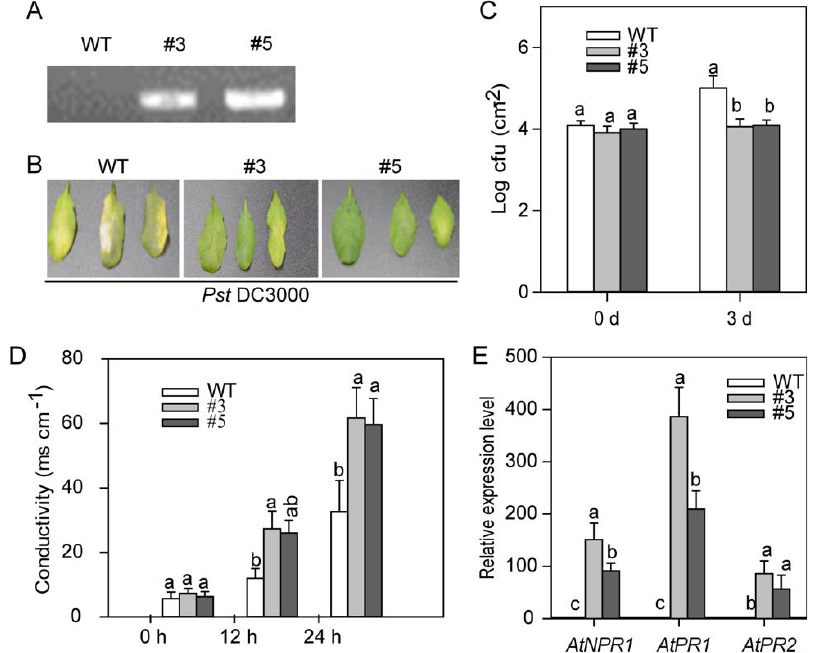
Figure 7. Enhanced resistance of CaASSH3 -OX over-expressing transgenic Arabidopsis plants to Pseudomonas Syringae pv tomato ( Pst ) DC3000 infection. ( A ) Extraction of genomic DNA and PCR analysis of CaASHH3 insertion in wild-type and CaASHH3 -OX transgenic lines. ( B ) Disease symptoms of wild-type or CaASHH3 -OX over-expressing transgenic plants inoculated with virulent Pseudomonas syringae pv tomato ( Pst ) DC3000 strains. Leaves of 4-week-old CaASHH3 -OX transgenic and wild-type Arabidopsis plants were infiltrated by needless syringe with a suspension (10 5 cfu mL − 1 ) of virulent Pst DC3000. Disease symptoms were photographed at 3 dpi. ( C ) Bacterial growth in leaves of wild-type and CaASHH3 -OX transgenic lines was investigated at 0 and 3 days after inoculation with virulent P. syringae pv tomato DC3000 (10 5 cfu mL − 1 ). ( D ) Quantification of electrolyte leakage from leaf tissues of CaASSH3 -OX transgenic and wild-type plants inoculated with virulent bacterial pathogen Pst DC3000. Samples were harvested at 0, 12, and 24 h post-inoculation. ( E ) Real-time quantitative PCR of defense-related genes in leaves of wild-type and CaASSH3 -OX transgenic plants after inoculation with virulent P. syringae pv tomato DC 3000 (10 5 cfu mL −1 ) at 24 h (hours) time interval. The relative transcriptional expressions levesl of mock-treated plants were normalized to 1. Error bars indicate the standard error. Data represent the means ± SE from four biological replicates. Different alphabetical letters indicate significant differences between means, as determined by Fisher ’ s protected LSD test: lower case letters represent p < 0.05.